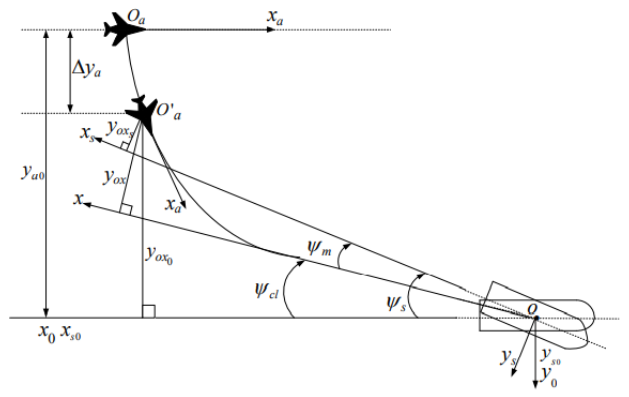
Figure 22. Lateral geometry of carrier aircraft landing.